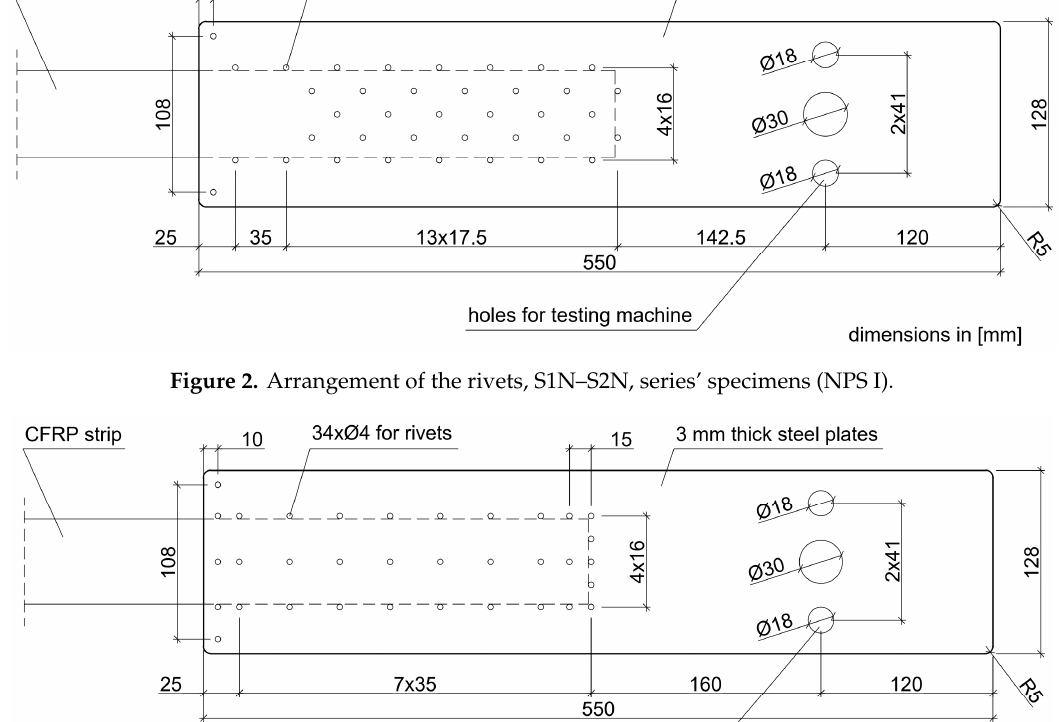
Figure 2. Arrangement of the rivets, S1N–S2N, series’ specimens (NPS I).